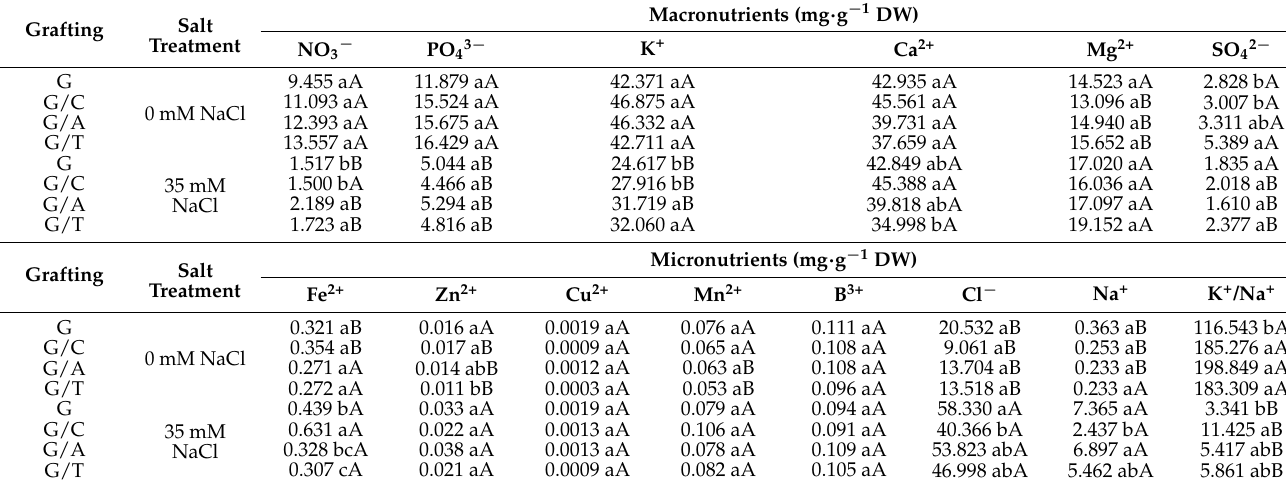
Table 1. Macronutrient and micronutrient concentrations in leaves of pepper plants of the commercial variety “Gacela F1” either non-grafted (G) or grafted onto the commercial rootstocks Creonte (G/C), Atlante (G/A), and Terrano (T/A), and cultivated under control (0 mM NaCl) and salinity (35 mM NaCl)